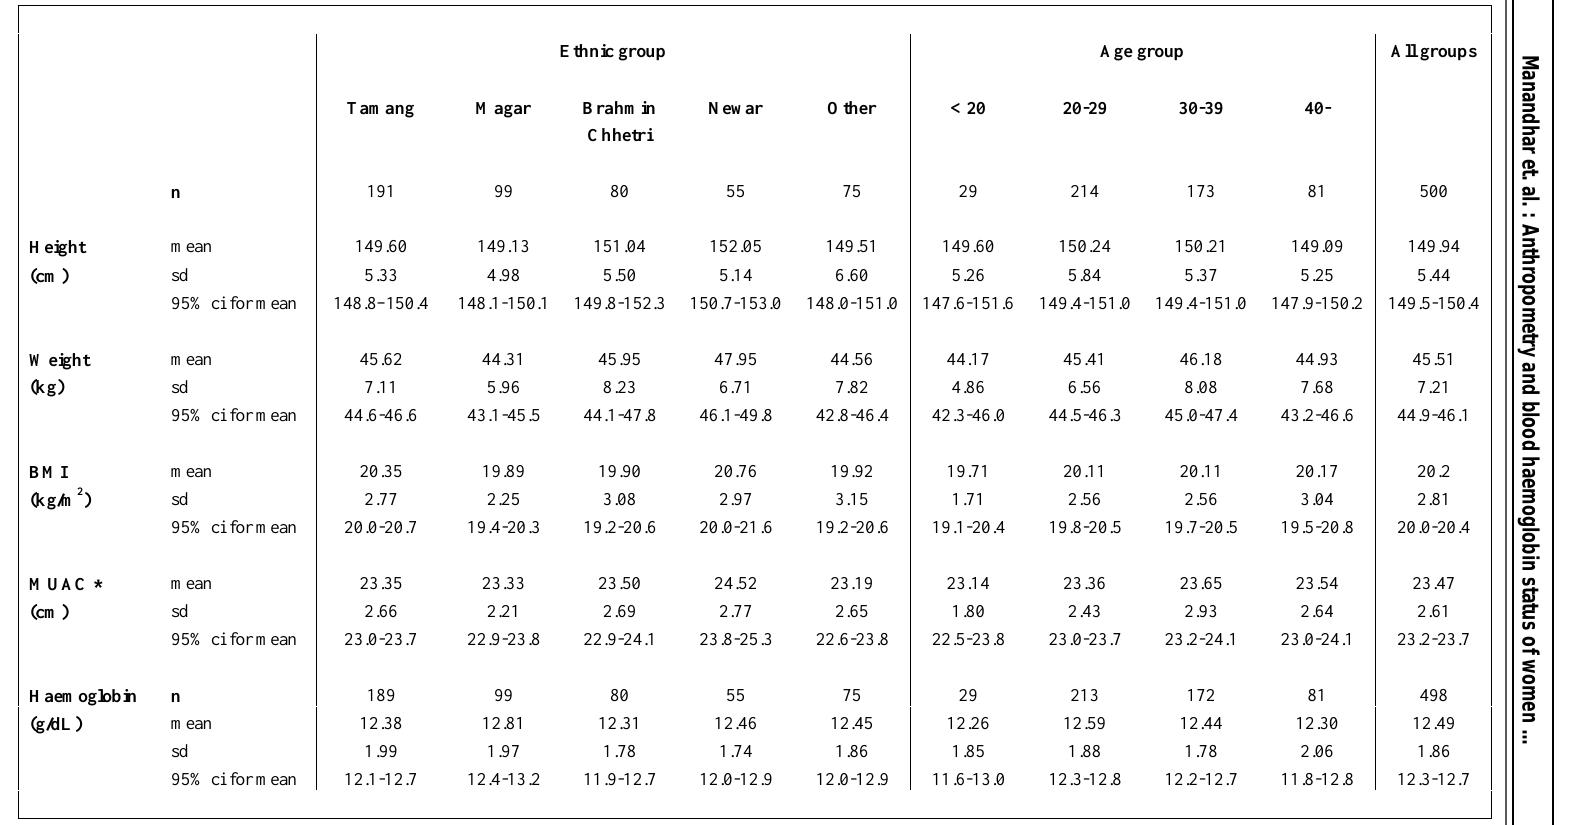
* in this group, there were 190 Tamang women and a total of